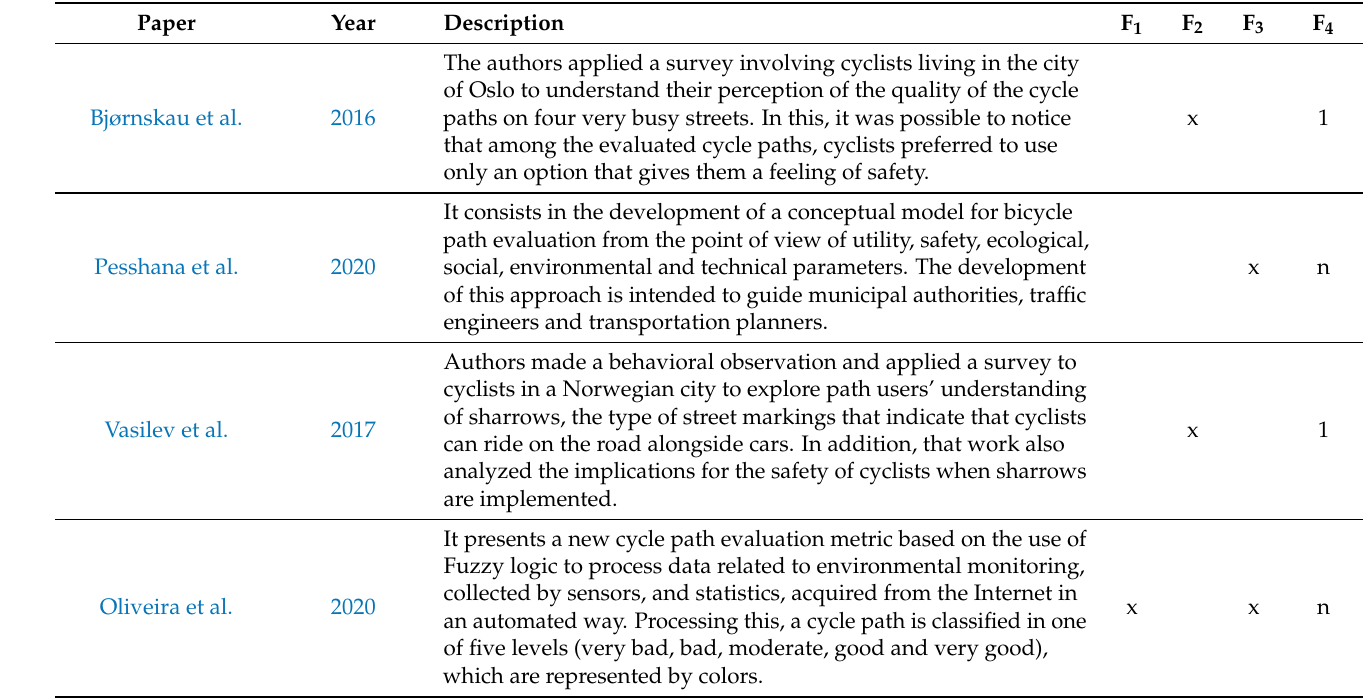
Table 3. Works focused on evaluation of cycle paths in terms of quality. Evaluation approach features: F 1 —automated